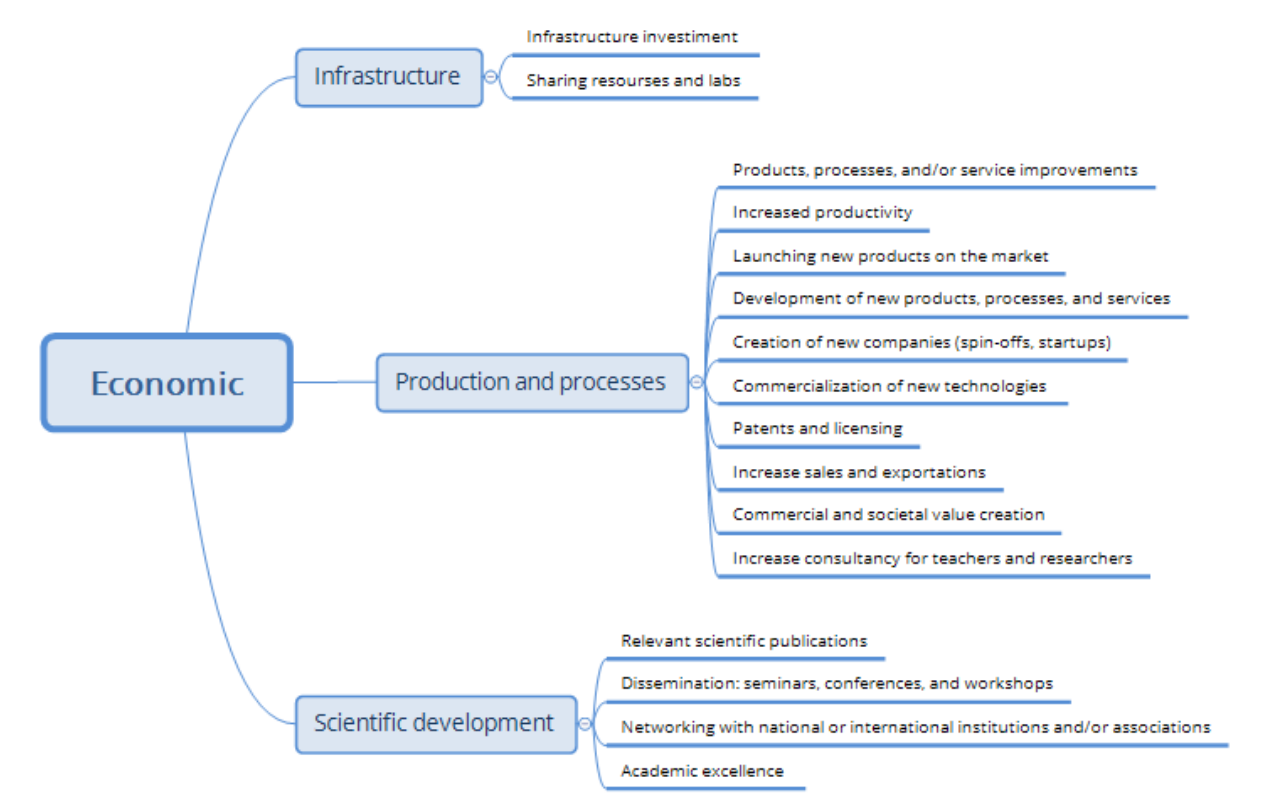
Figure A1. Economic impacts of university–industry collaborations. Table A4. Economic impacts of university–industry collaborations.